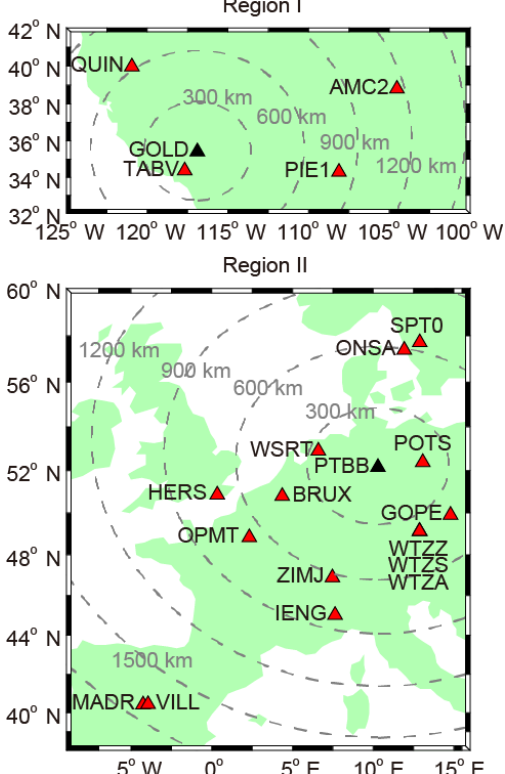
Figure 1. Geographical location of the selected IGS stations in the US region (Region I) and Europe region (Region II). The black tri- angle in each plot is the reference